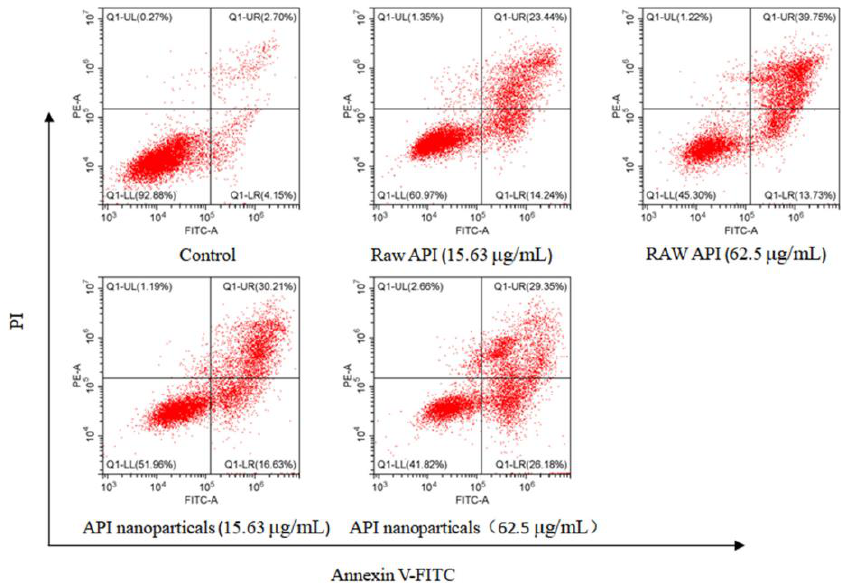
Figure 15. Analysis of API nanoparticle-induced HepG2 cell apoptosis by Annexin V-FITC/PI double staining method.